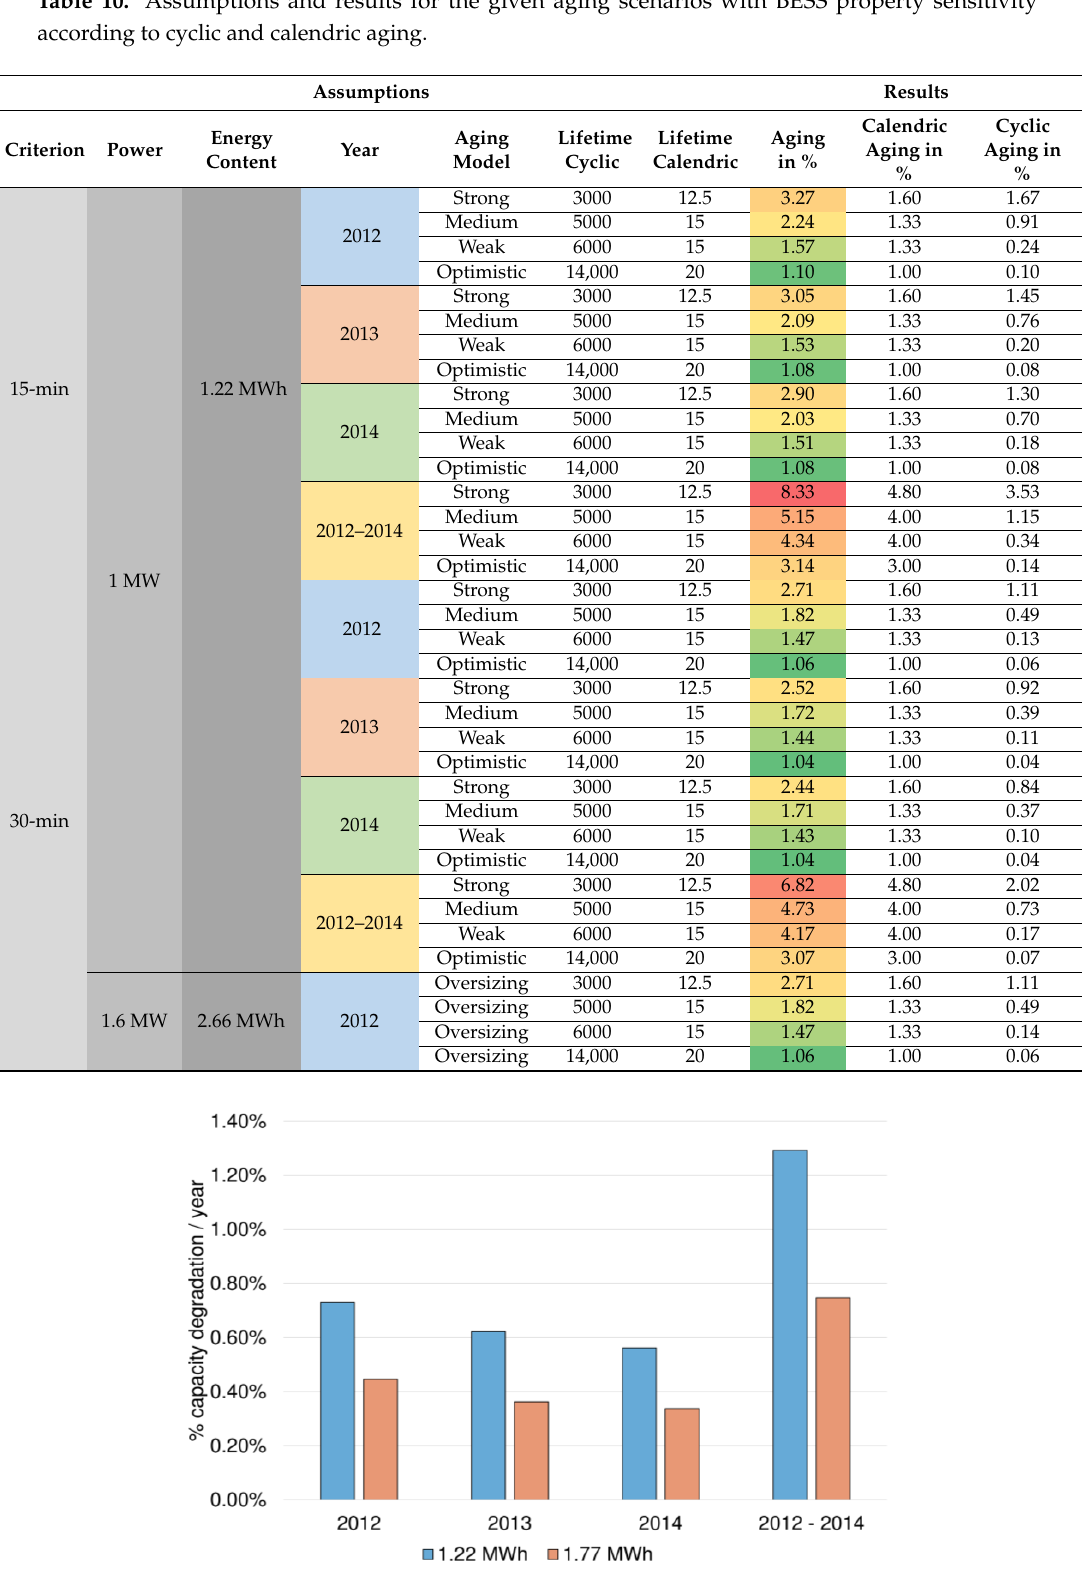
Figure 12. Influence of BESS sizing on aging by year.